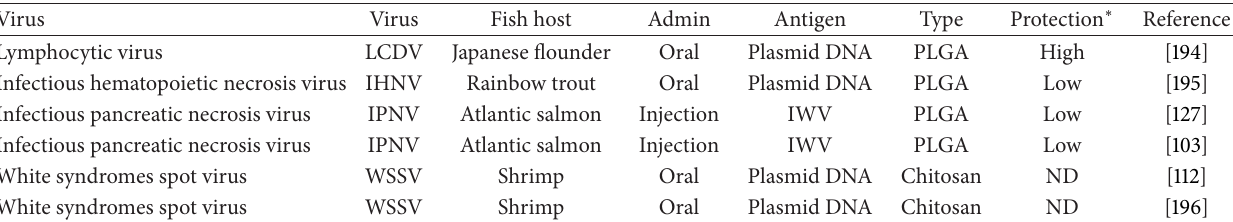
Table 4: Nanoparticle